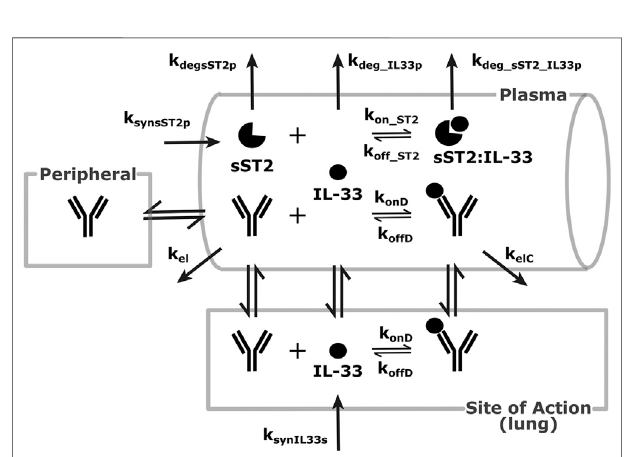
FIGURE 4 | Modeling scheme of an anti-IL-33 mAb. The general processes are similar to the default scheme described in Figure 1 , with several details adapted to the IL-33 scenario. IL-33 is synthesized at the SoA (lung) and distributes to the plasma. There, it can bind sST2 or get eliminated.sST2issynthesizedandeliminatedinplasmaonly.ThesST2:IL-33 complex clears in the plasma.